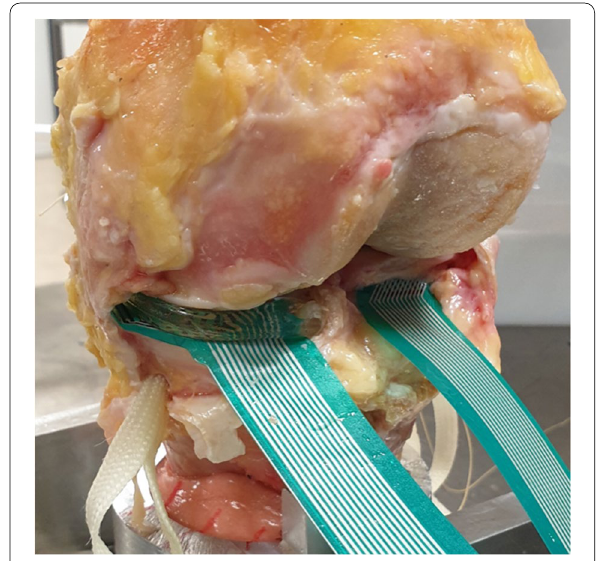
Fig. 9 Second-generation meniscus prosthesis and sensor in a cadaveric knee